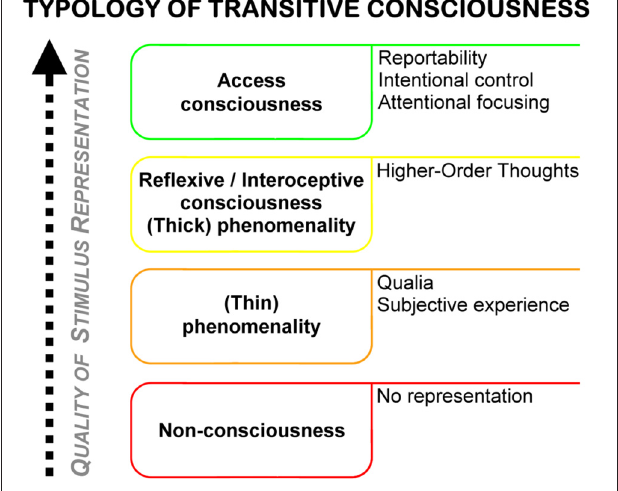
FIGURE 1 | Typology of transitive consciousness, based on different theoretical accounts from the philosophy of mind (see text for further details). Right column outlines defining properties of the different types of